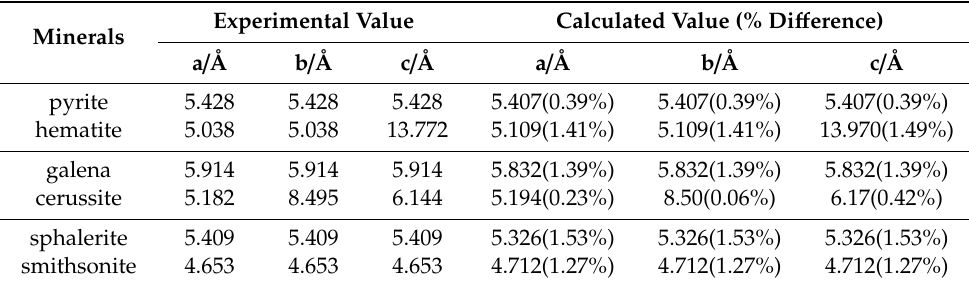
Table 1. The comparison between the lattice parameters of the optimized model and the experimental results of the bulk.